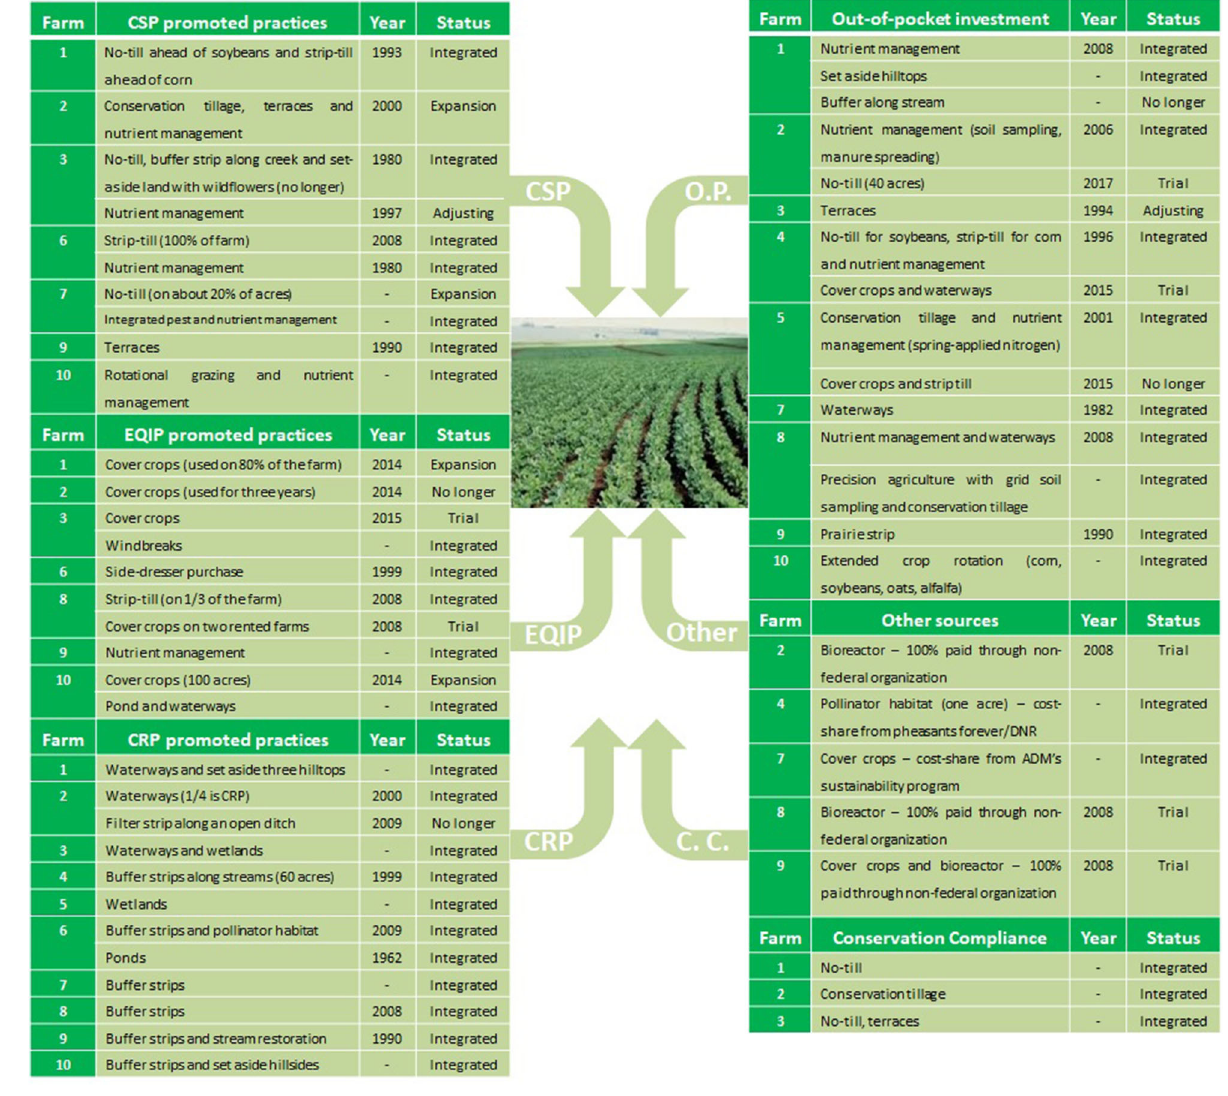
FIGURE 1 | Conservation-related practices adoption process by farm environmental leaders in Iowa. Source: Field research. Interviewed farmers define reduced tillage practices as follows: conservation tillage–tillage with some residue left covering soil; strip-tillage–disturbs only the portion of the soil that is to contain the seed row; no-till–no soil disturbance. Conventional tillage is defined as tillage with no residue left covering soil. In the case of conservation compliance, only farmers with HEL were